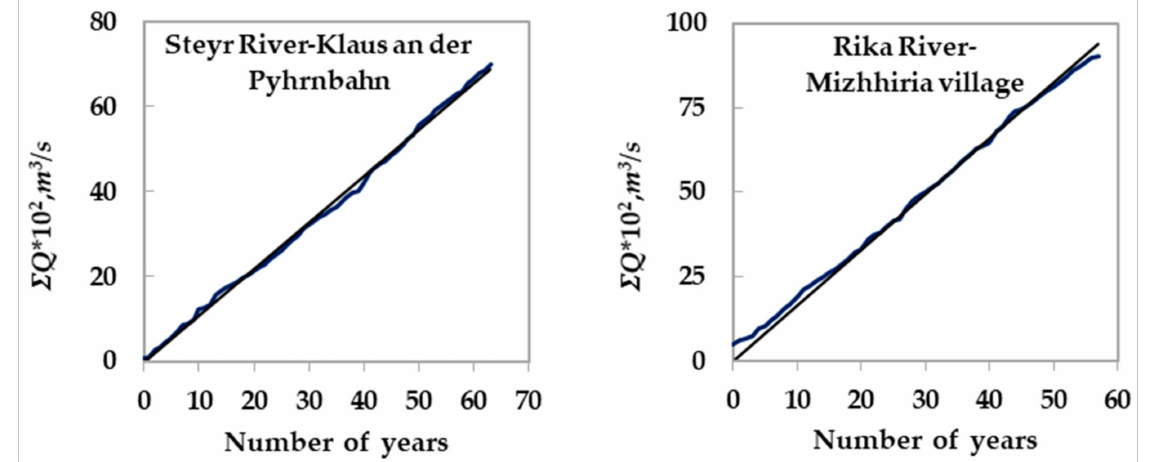
Figure 3. Mass curves of winter floods in the upper Steyr ( left panel) and upper Rika ( right panel) River basin.